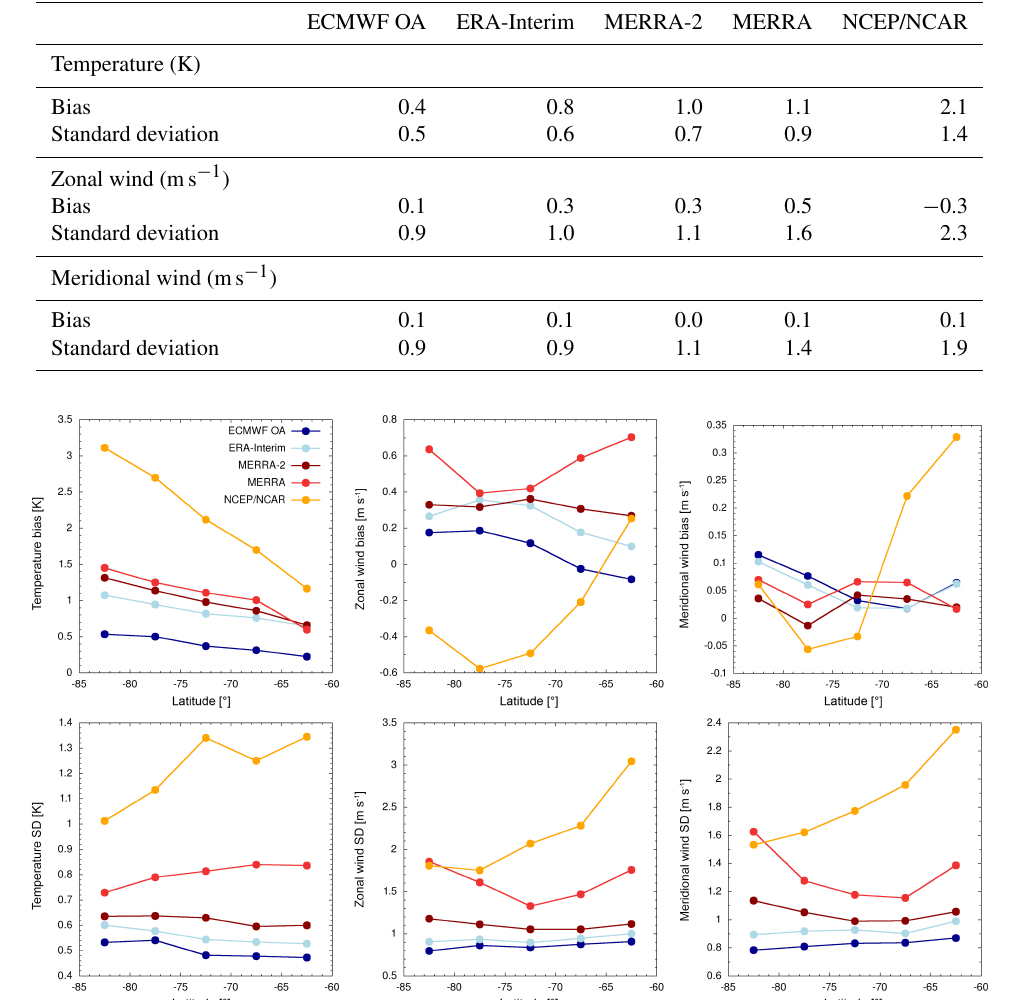
Table 3. Statistics of low-pass-filtered meteorological analyses minus Concordiasi balloon observations (based on N ≈ 2 . 52 × 10 6 measure- ments)